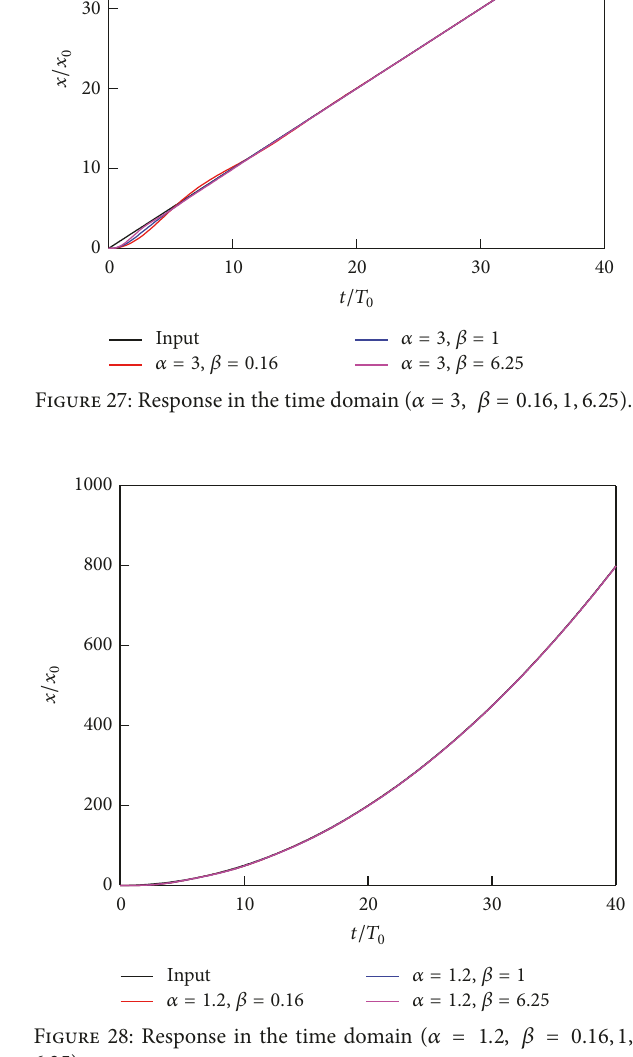
Figure 26: Response in the time domain ( 𝛼 = 2, 𝛽 = 0.16, 1, 6.25 ).